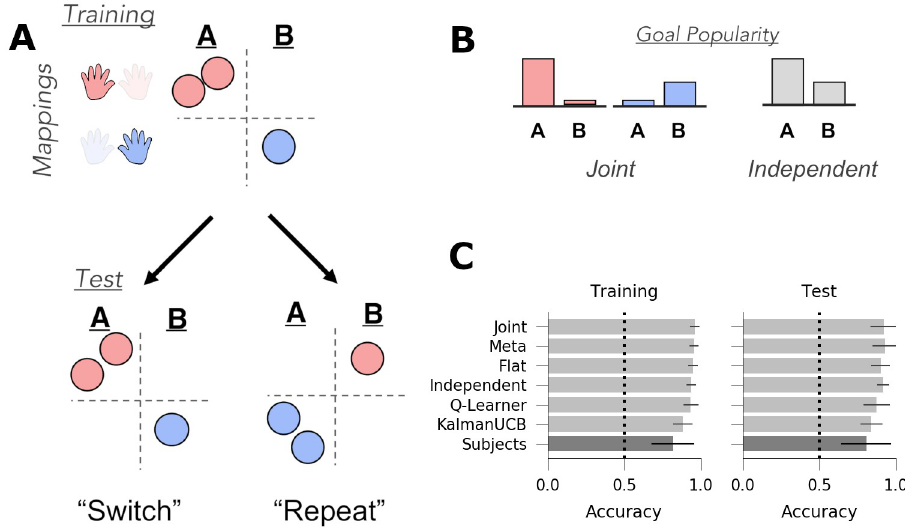
Fig 3. Experiment 1: Joint structure. A : Task Design: During training, subjects saw three contexts (depicted here as circles) in which a given transition function (mappings, indicated by red/blue hands) was always paired with the same reward function (goals A or B), suggestive of joint structure. In the test phase, subjects saw three novel contexts in which the relationship between transitions and goals was either repeated (i.e., each goal was paired with the same mapping as seen during training) or switched (goal B associated with the mapping that was previously paired with goal A). The switch vs. repeat manipulation was conducted between-subjects. B : Goal popularity in the training environment as a function of mapping (as tracked by a joint agent, left) and collapsed across all contexts (as tracked by an independent agent, right). C : Goal accuracy of models (light grey) and human subjects (dark grey) across all trials in the training and test contexts. Chance performance denoted with dotted line. Error bars denote standard deviation.